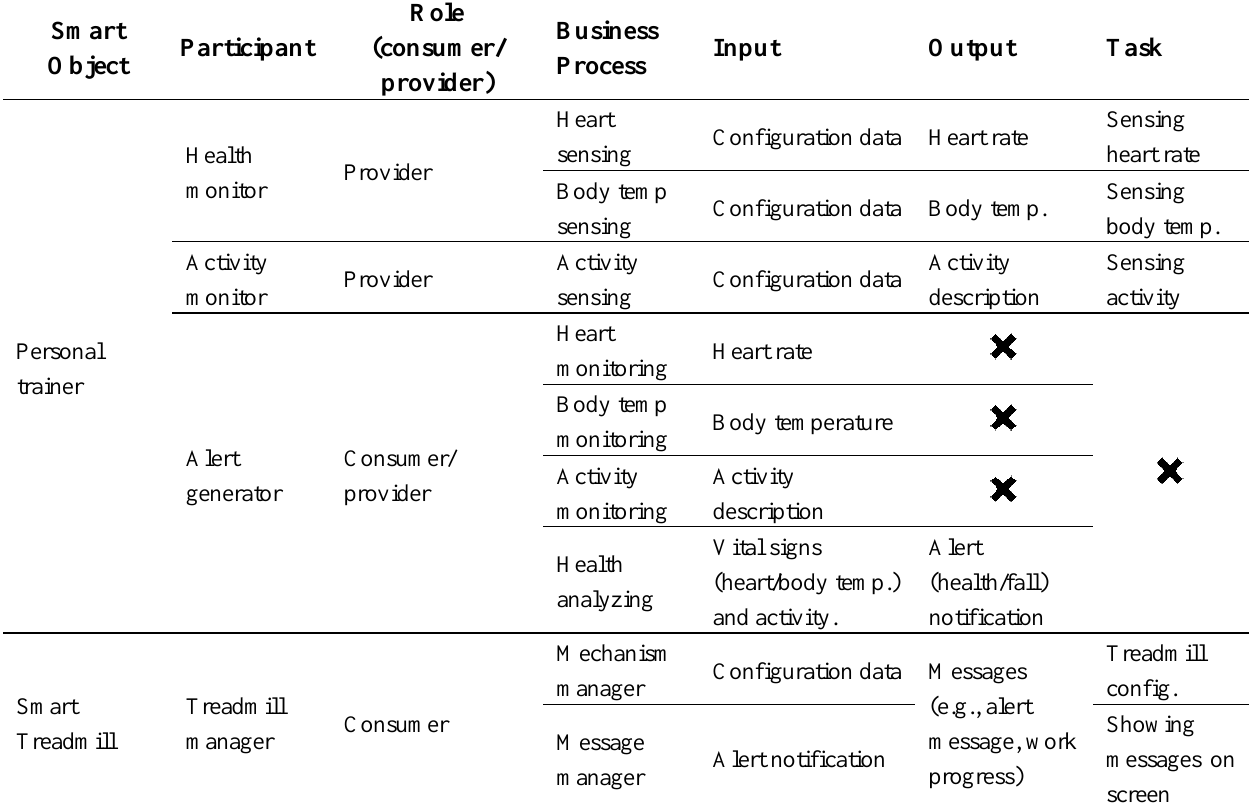
Table 8. Report of the analysis of service aspects in the smart